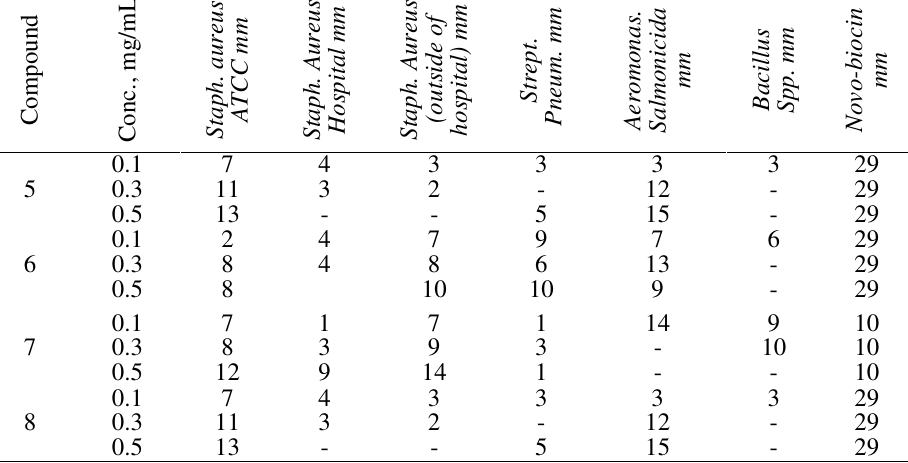
Table 1. Microbiological activity of newly synthesized